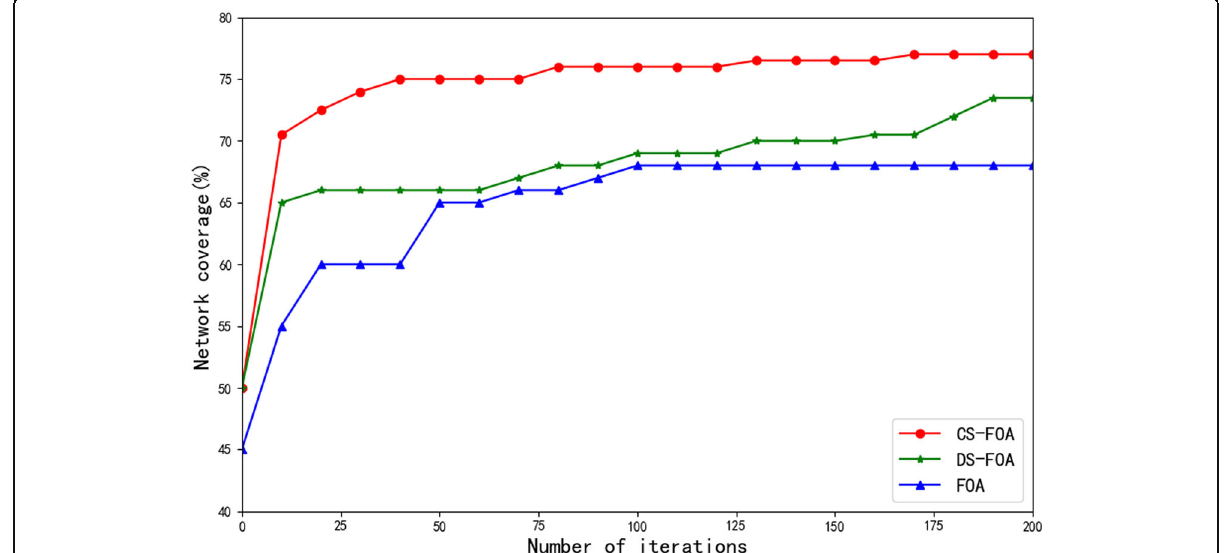
Fig. 6 Comparison of algorithm convergence. The theoretical maximum coverage rate is 78.5%. On this basis, the coverage of the above